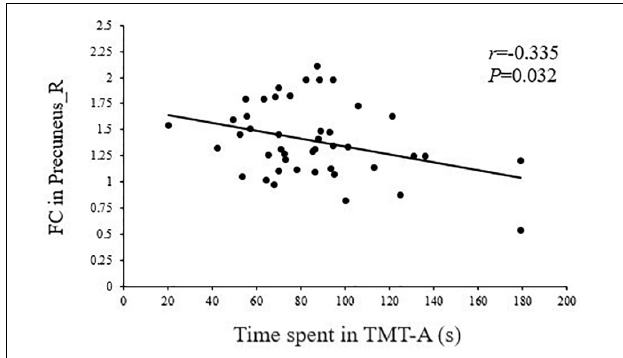
FIGURE 5 | Correlation between TMT-A scores and the right precuneus within the default mode network (DMN) in T2DM patients ( r = –0.335, P = 0.032).